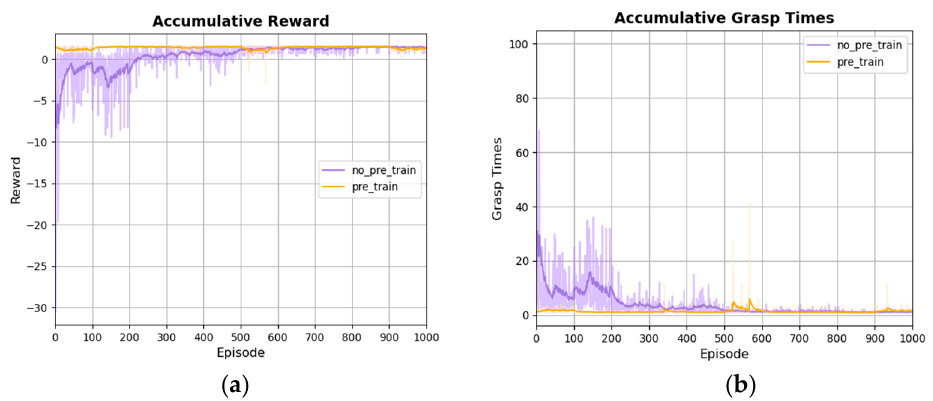
Figure 14. Training results for the case of randomly placed objects: the yellow line represents the results of exploiting transfer learning (i.e., use the weights for the case of fixed object poses as the initial weights), while the purple line shows the results without using transfer learning. ( a ) Accumulated reward for each episode; ( b ) number of grasping attempts for each episode. Table 2. Total training time and total number of grasping attempts.